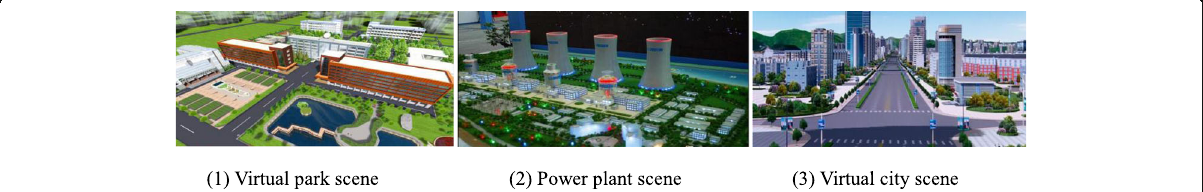
Fig. 1 The 3D scene test data source of performance bottleneck analysis and resource optimized distribution method. (1) Virtual park scene of the data source. (2) Power plant scene of the data source. (3) Virtual city scene of the data source. This group figure describe the test data source of performance bottleneck analysis and resource optimized distribution method for IoT cloud rendering computing system in cyber-enabled applications. These data source provided by Middlebury, Canada (http://pointclouds.org/ [23]). We select the test models with the largest number of patches, vertexes, and the largest amount of data as experimental test model data. These representative models are selected according to the standard of include most IoT cloud rendering computing system scenarios and most amount of data. Moreover, these models have typical loading times and operational characteristics. If our algorithm works well on these characteristics models, it will work well on other scene models as well. In this group of models and scenes, we selected some 3D model test data set from Middlebury, Canada. The first sub-figure is a virtual park scene and related models, the second sub-figure is a power plant scene and related models, and the third sub-figure is a larger virtual city scene and related models. The following are advantages of scene and models:(1) under different influence of network congestion, these scenes and models show different rendering effects. These models are greatly influenced by different network speed, network congestion, algorithm, and parameters. So this kind of model can distinguish different network congestion situations and different algorithms efficiency. It could truly distinguish the advantages and efficiency of different method. (2) These scenes and models contain more vertexes, edges, and triangular patches, which can distinguish complex method effect easily in graphics. (3) These scene and models include the brightness, hue, and saturation of scene color. These scenes and models will show different rendering effects under different rendering method and procedures. These scenes and models have high discrimination and expressiveness for different algorithms